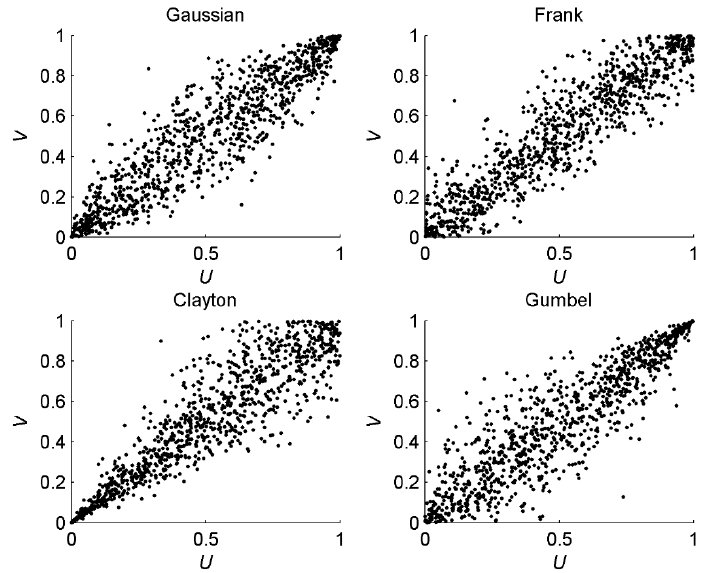
Figure 3. Random samples (sample size 1000) from Gaussian, Frank, Clayton, and Gumbel copulas.